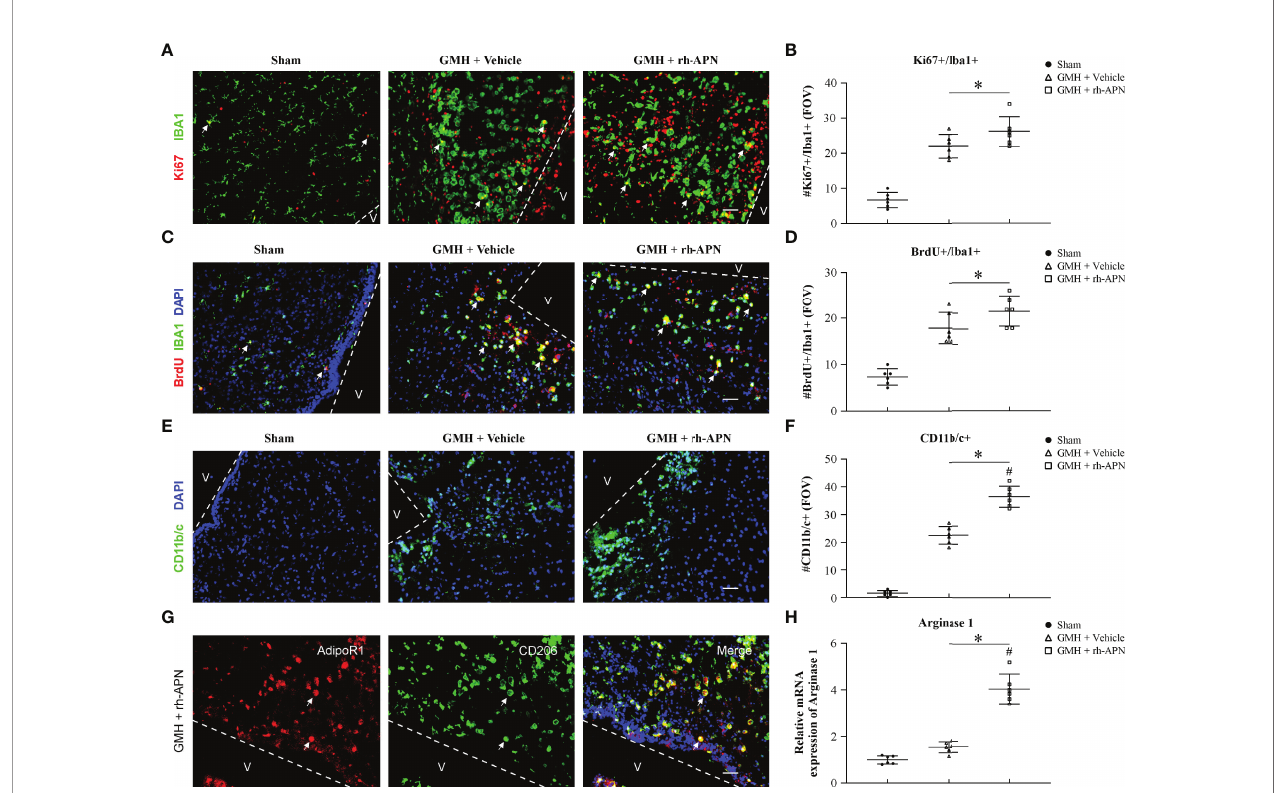
FIGURE 5 | rh-APN promoted M2 microglia accumulation in the periventricular region at 72 h after GMH. (A, C) Representative images of immuno fl uorescence staining and quanti fi cation (B, D) depicted accumulation and proliferation (Ki67+/Brdu+, red) of microglia (Iba+, green) in the periventricular region. (E, F) Representative images of immuno fl uorescence staining and quanti fi cation showing activated microglia/macrophages (CD11b/c+, green) in the periventricular region. Scale bar = 50 m m. Dots in (A-G) represent data from individual pups. FOV=2.3 × 10 6 m m 3 . Values are expressed as mean ± SD. ANOVA, Dunnett. n = 6 for each group. * P < 0.05 compared to sham, # P < 0.05 compared to GMH + Vehicle. (G) Representative images of immuno fl uorescence staining showing co-localization of AdipoR1 (red) and M2 microglia (CD206+, green) in the periventricular regions after GMH. Scale bar = 50 m m. n = 3 for each group. Arrows indicate AdipoR1 colocalized with M2 microglia. (H) qRT-PCR assay showed that rh-APN signi fi cantly increased the mRNA expression of Arginase-1 at 72 h post-GMH. Values are expressed as mean ± SD. ANOVA, Dunnett. n = 6 for each group. * P < 0.05 compared to sham, # P < 0.05 compared to GMH +